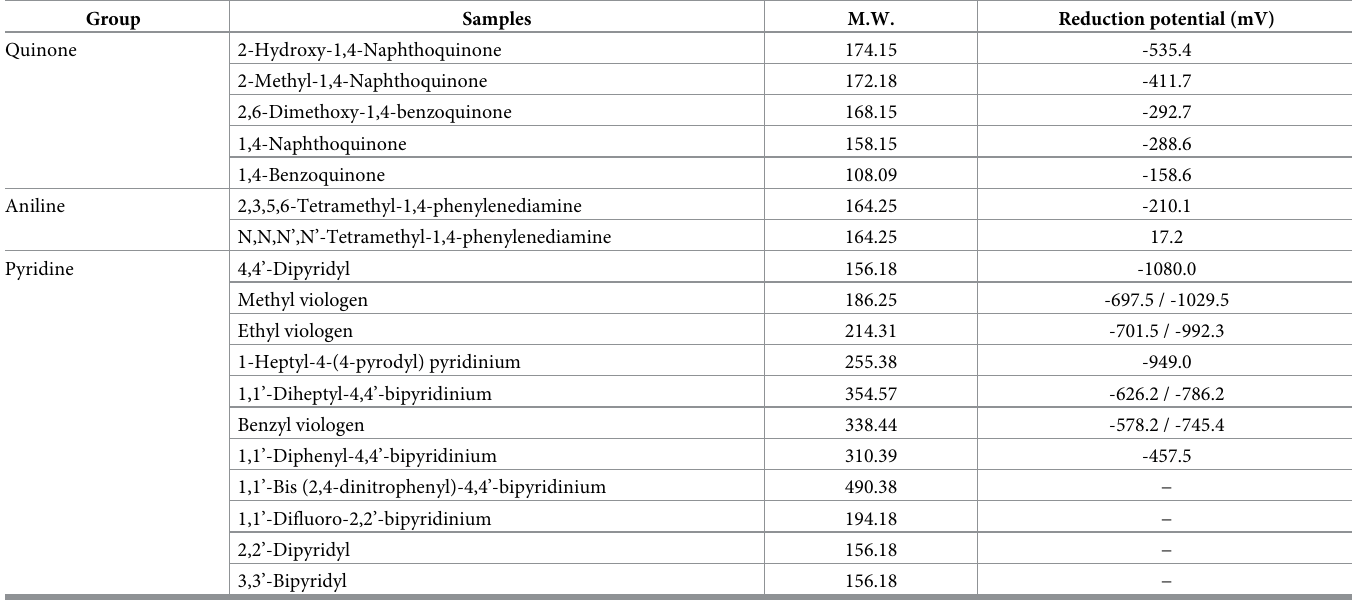
Table 1. Classification and reduction potential of the used mediators.